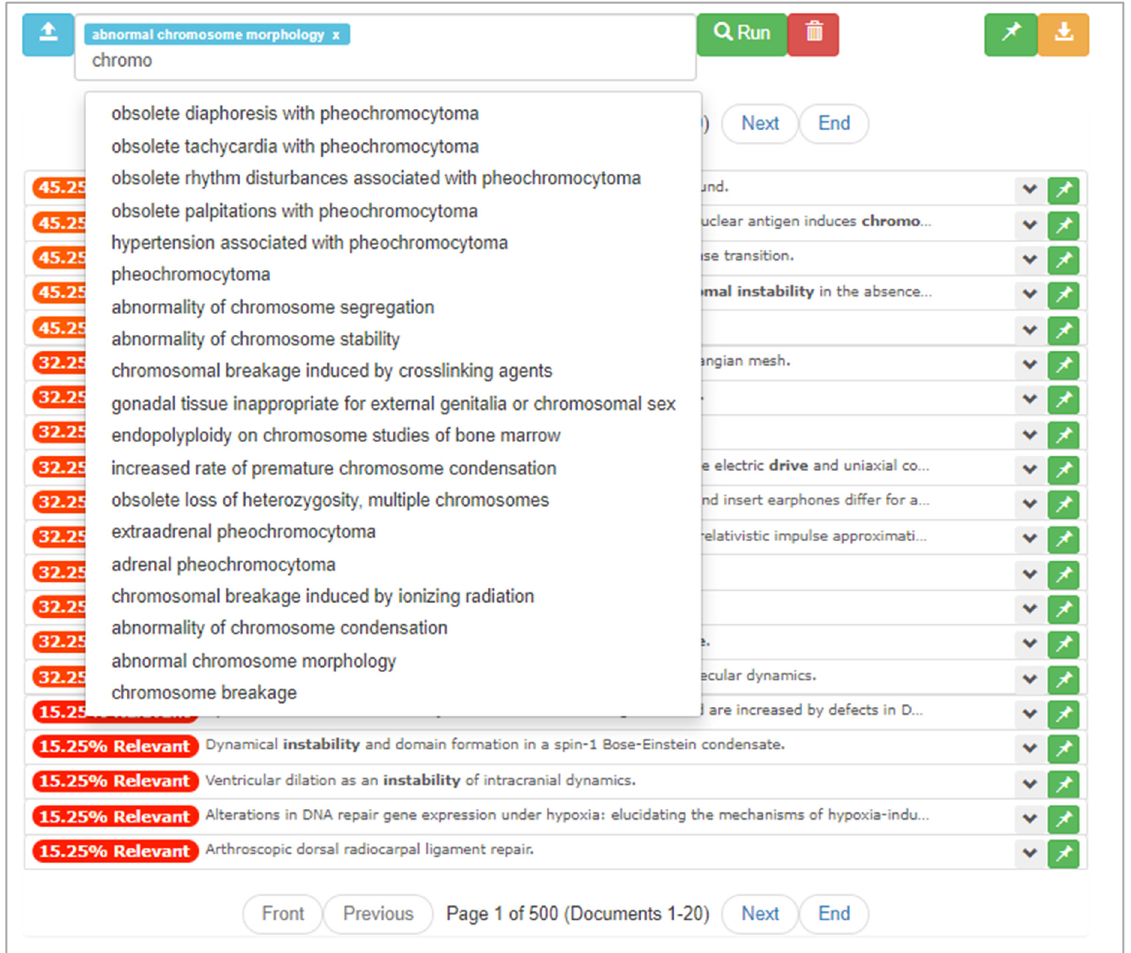
Figure 11. ONTSI while the user is presented with mediating opportunities from the expert–defined Human Phenotype Ontology.